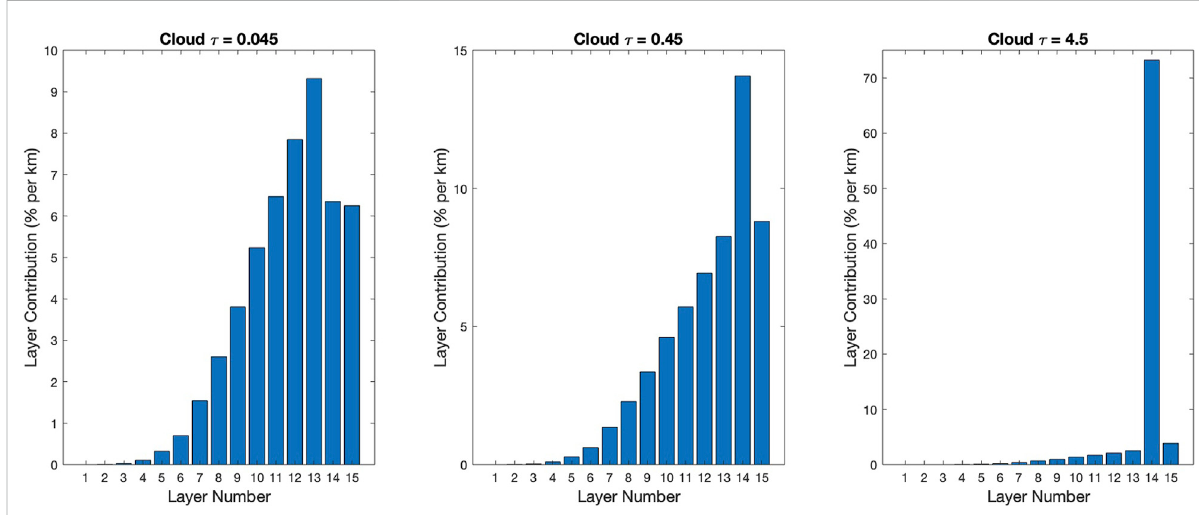
FIGURE 5 Leftpanel:SameastheleftpanelofFigure3exceptthatthetotalcloudopticaldepth(COD)forlayers14and15wasdecreasedbyafactor100to 0.045. Middle panel: Same as the left panel of Figure 3 except that total COD for layers 14 and 15 was decreased by a factor 10 to 0.45. Right panel: Same as left panel of Figure 3 for a total COD of 4.5 in layers 14 and